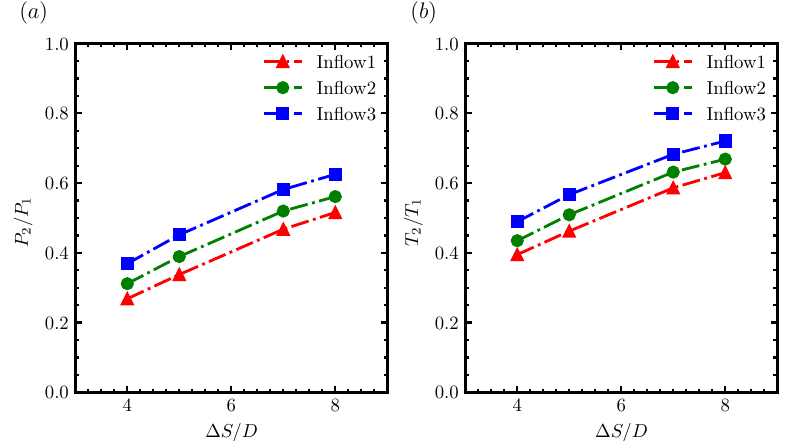
Figure 3. Power ( a ) and thrust ( b ) of the waked turbine normalized by those of the first turbine for different turbulent